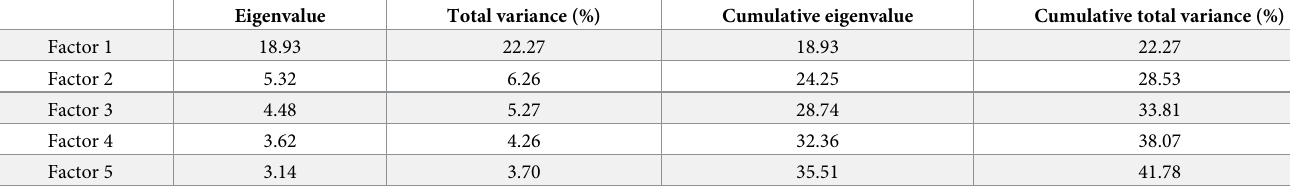
Table 1. Eigenvalues and percentage of variance explained for the 5-factor solution (Stage 2).